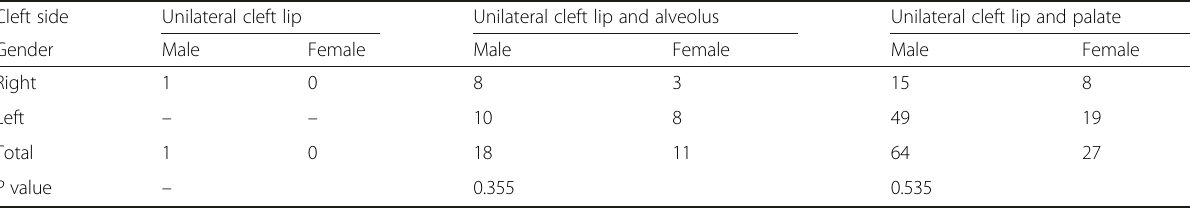
Table 3 Distribution of samples according to gender and relationship between gender and affected side